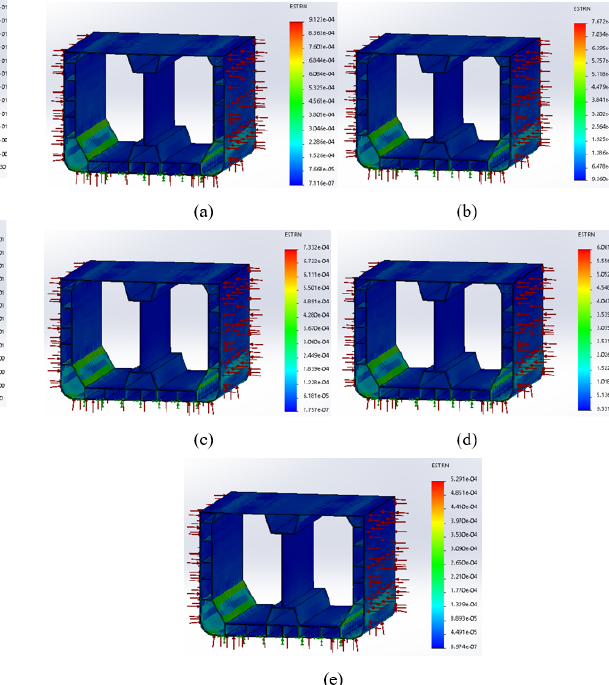
Figure 13: (a) Deformation contour plot at various drafts: (a) at draft 9 m, (b) at draft 8 m, (c) at draft 7 m, (d) at draft 6 m, and (e) at draft 5 m.